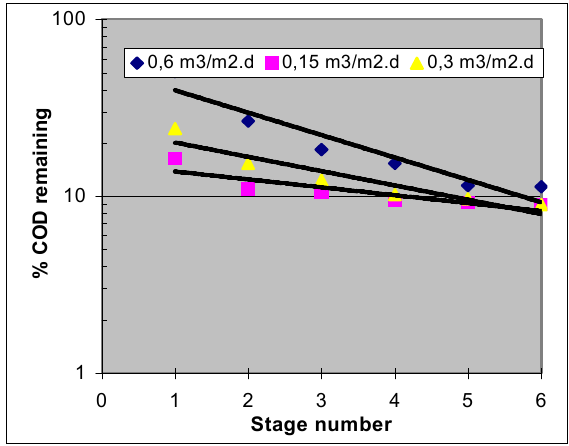
Figure 5: Percent COD remaining per stage for typical municipal wastewater at constant concentration, and varying flow rates [31]